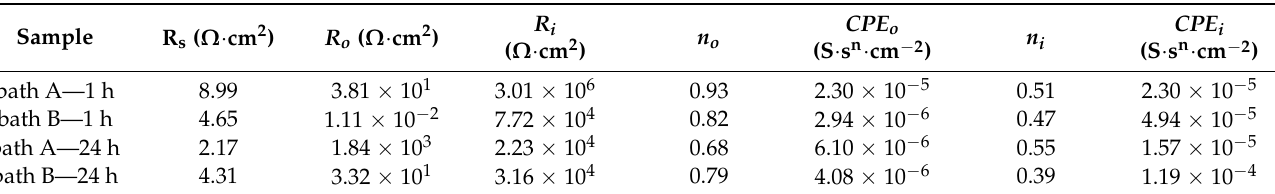
Table 3. Electrochemical impedance parameters of the PEO-treated Cp-Ti at two different aluminate concentrations: low concentration (bath A) and high concentration (bath B). The impedance tests were performed in simulated seawater (3.5 wt.% NaCl solution) under a frequency range of 10 6 to 0.1 Hz. With the equivalent circuit model displayed in the inset of Figure 6c–d, the values were produced